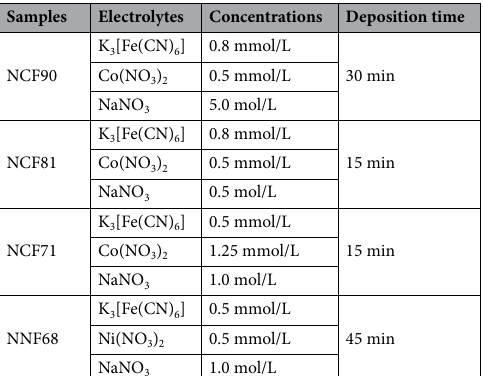
Figure 5. (a) In situ IR spectra of the NCF81 film at 330 K against x in the oxidation process from x = 1.24 to x = 0. Black broken curve at x = 1.24 was obtained after the measurement. α is absorption coefficient; α = where d is the film thickness, I 0 is the incident beam intensity, and I is the transmitted beam intensity, respectively. Spectra are vertically shifted for clarity. The horizontal arrows indicate the empirical region for the CN - stretching modes in [Fe II (CN) 6 ] 4- and [Fe III (CN) 6 ] 3- , respectively. Origin of the band marked by asterisk is unknown. (b) Charge curve of the NCF81 film at 330 K against x at 1.4 C. The voltages of the electrochemical cell were scaled to vs. Na/Na + .